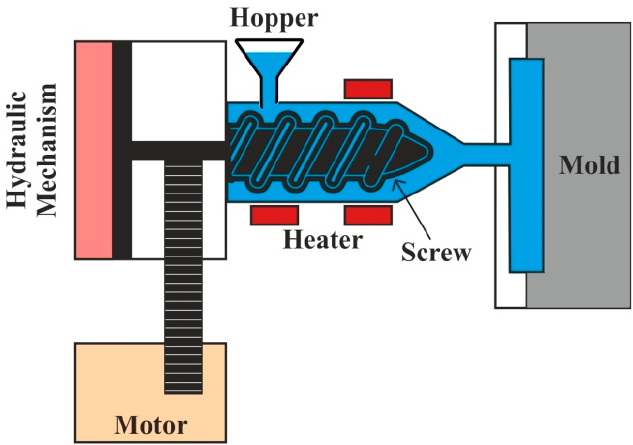
Figure 10. Injection molding process.